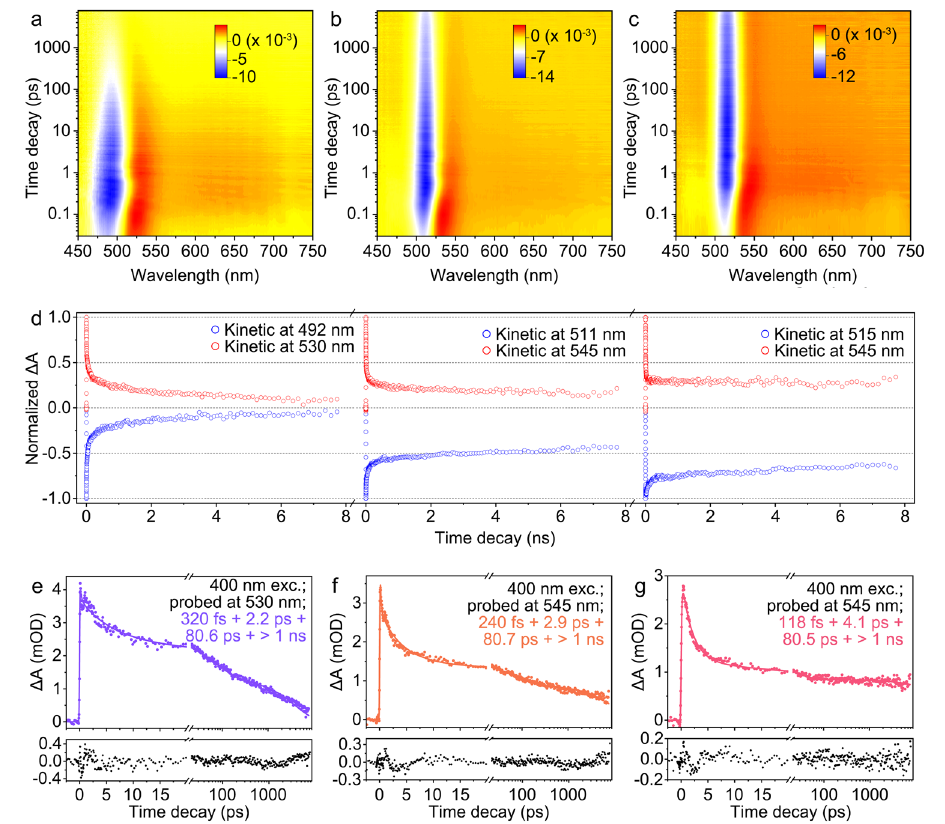
Fig. 3 | Comparison of femtosecond-TA spectral features and their electron dynamics of Au-1, Au-2, and Au-3 NCs. a – c Femtosecond-TA maps of Au-1, Au-2, and Au-3 NCs upon 400nm excitation. The scaling of the color scales is the absorption intensity, and the units are milli-optical density. d Normalized ESA and GSBkinetictracesprobed at492and 530nm for Au-1NCs, 511 and545nm forAu-2